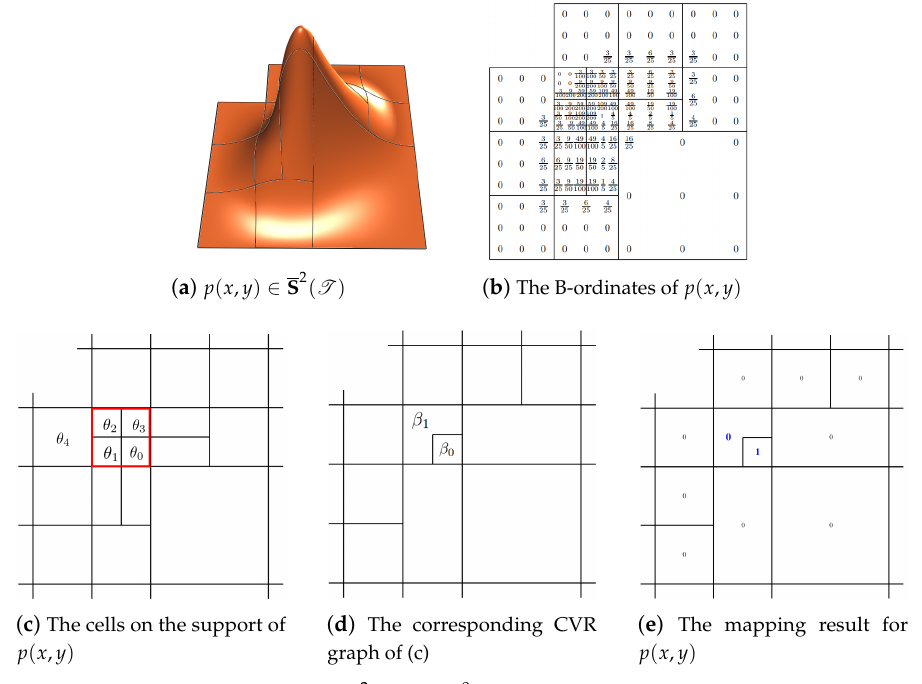
2 ( 0 ( T ) to S G ) . The red box in ( c ) denotes the T-rectangle